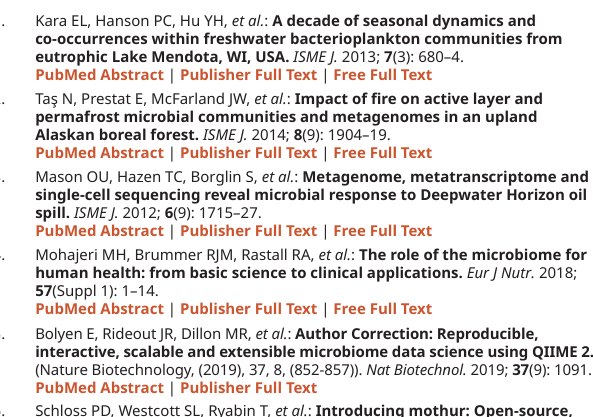
Supplementary Figure S1: MetaPhlAn2 Genus-Level Supplementary Figure S2a: HUMAnN2 Gene Family Abundance